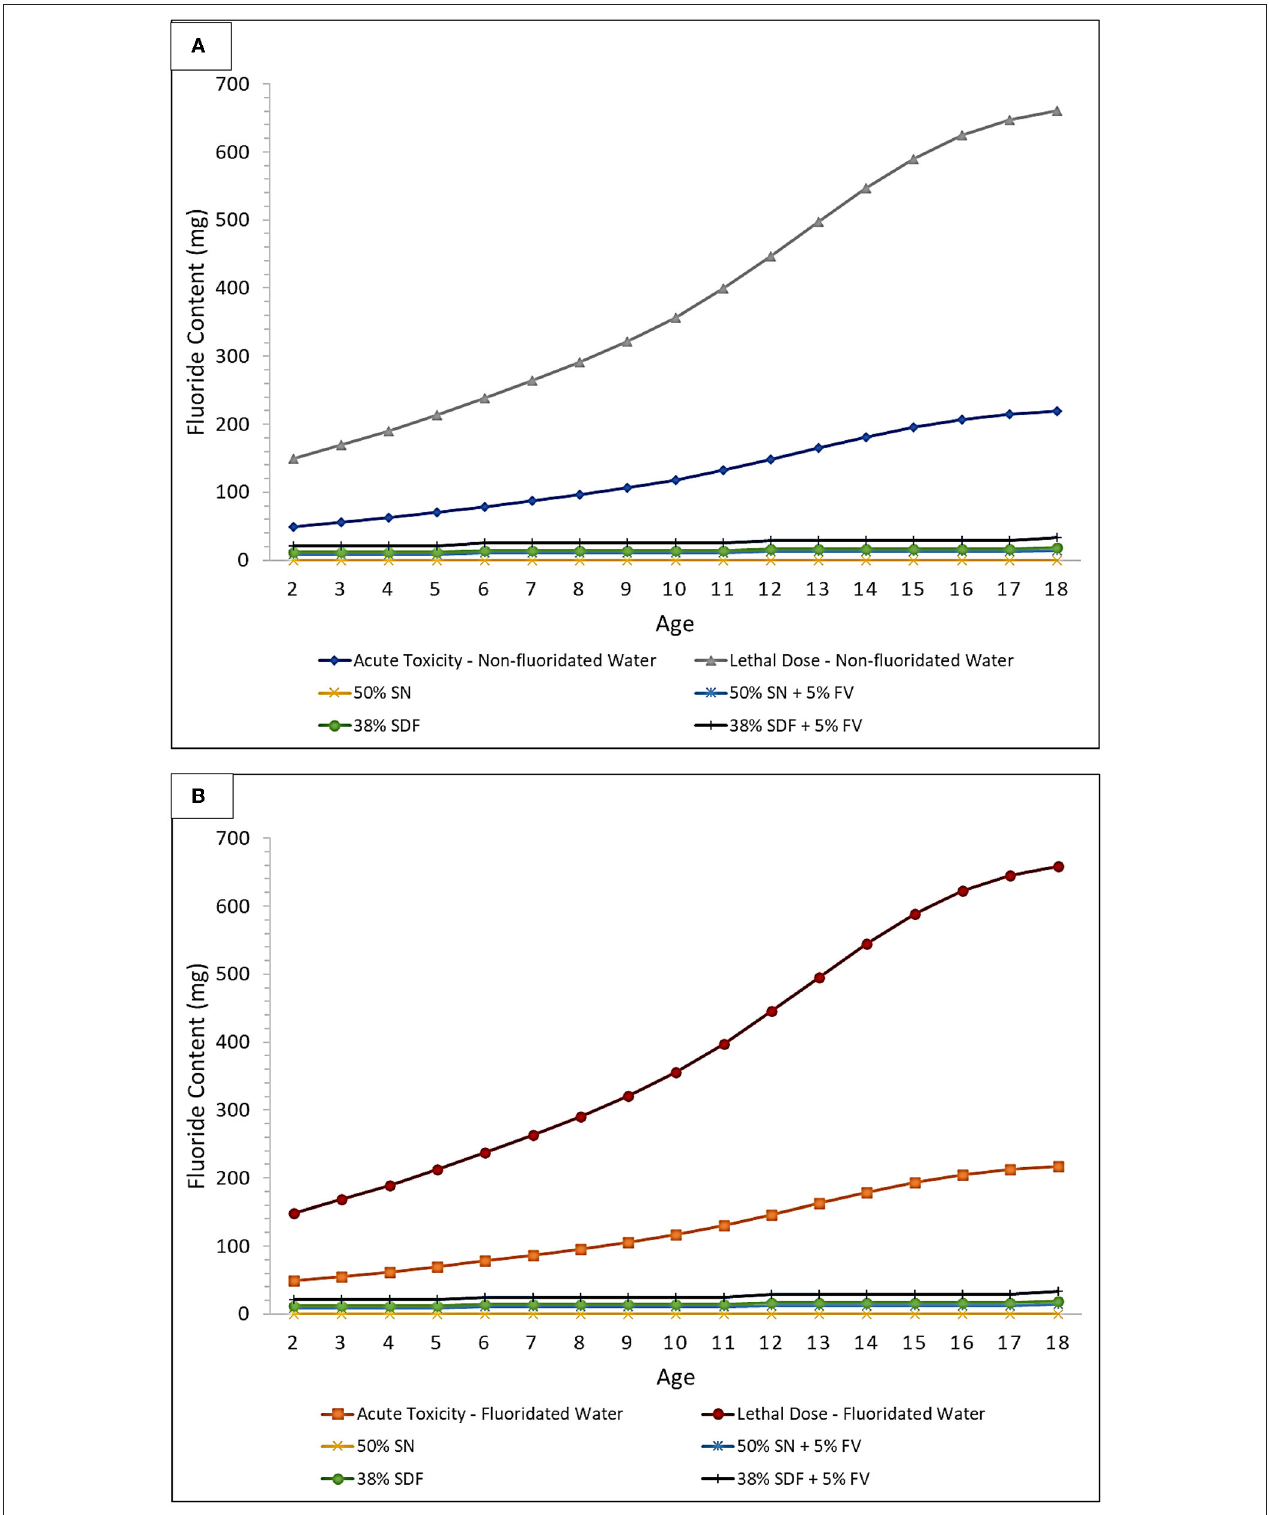
FIGURE 3 | Acute toxicity and CLD thresholds of fluoride for silver nitrate (SN) and SDF both with and without a sodium fluoride-containing varnish (FV) in (A) non-fluoridated and (B) fluoridated water environments. Treatment comparison against the fluoride Acute Toxicity and CLD Thresholds (including considerations for the ingestion of fluoridated water, or not, and also toothpaste up to the age of 6 years) using 10 µ l of 50% (w/v) SN, or 10 µ l of 38% (w/v) SDF, and both with and without the application of 20 µ l of a 5% (w/v) FV. These plots were derived using the assumption that every tooth is treated for each age group considered, and all ages are within the 3% weight group, to further demonstrate the safety margin in a worst-case-scenario.